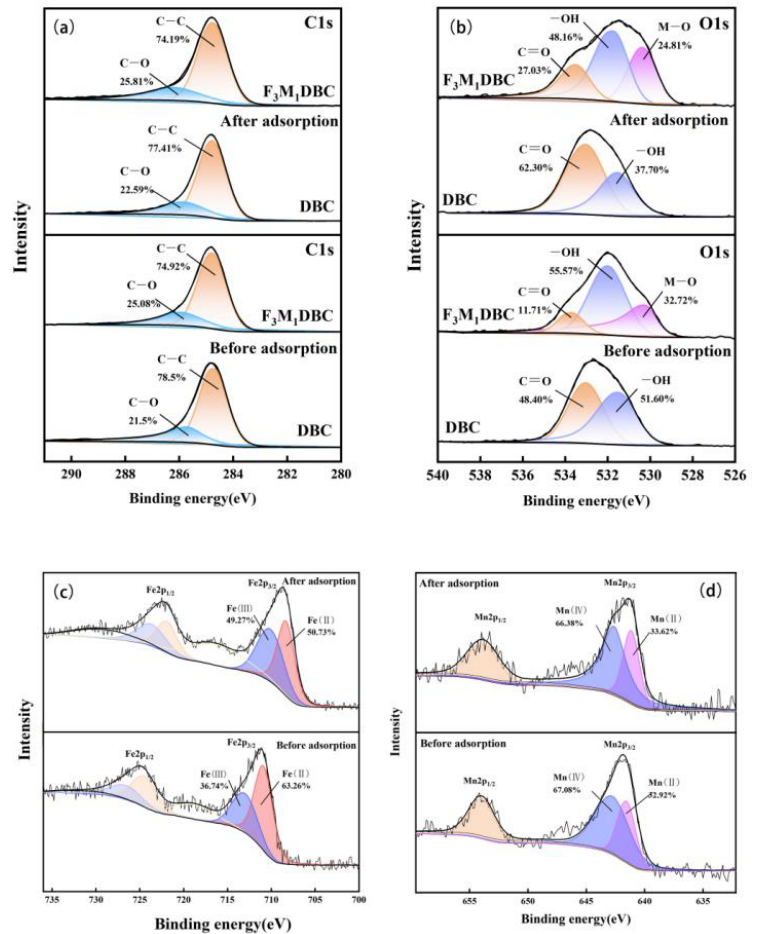
Figure 8. The XPS spectrum of DBC and F 3 M 1 DBC before and after adsorption. The C1s XPS spectrum ( a ), the O1s XPS spectrum ( b ), the Fe XPS spectrum ( c ), and the Mn XPS spectrum ( d ) of DBC and F3M1DBC before and after atrazine adsorption.